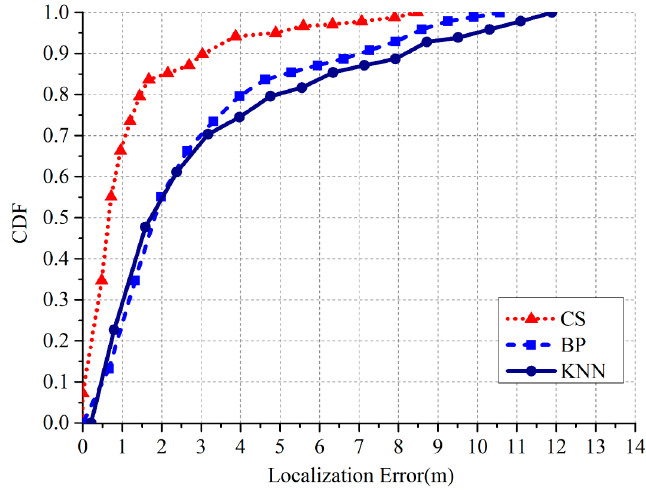
Figure 17. CDF of the localization errors under different pattern recognition algorithms. Table 3. Localization results under a different Clustering I process and without the Clustering I process.